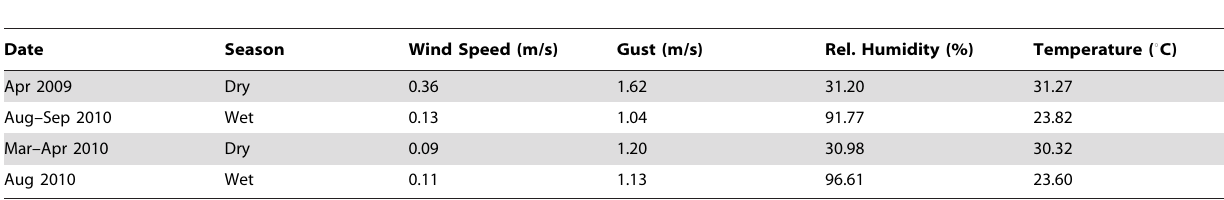
Table 1. Weather on nights when experiments were conducted in